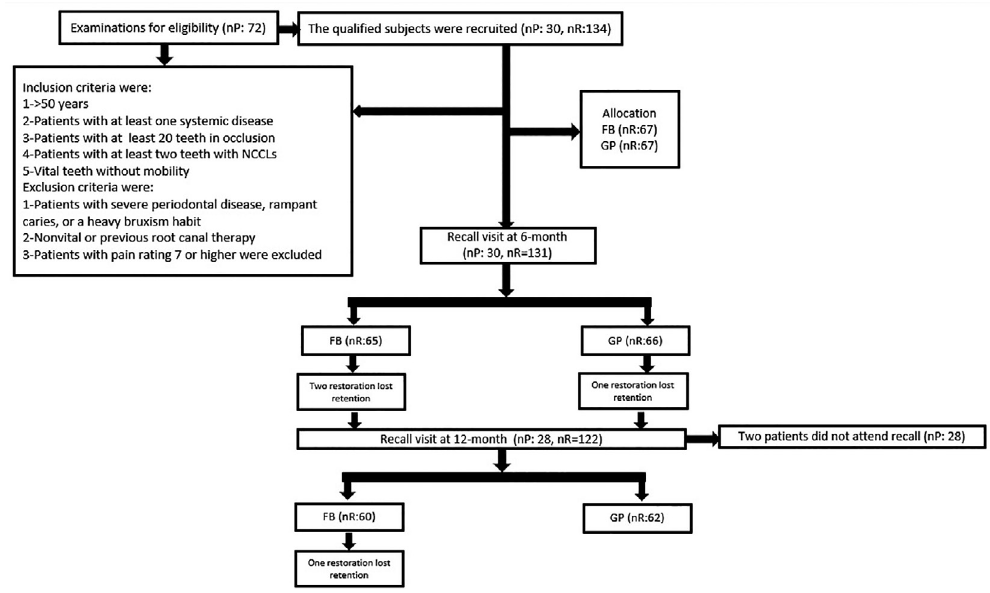
Figure 1- Flow diagram of the study. FB: Fuji Bulk, GP: G- ænial Posterior, nP: number of patients, nR: number of